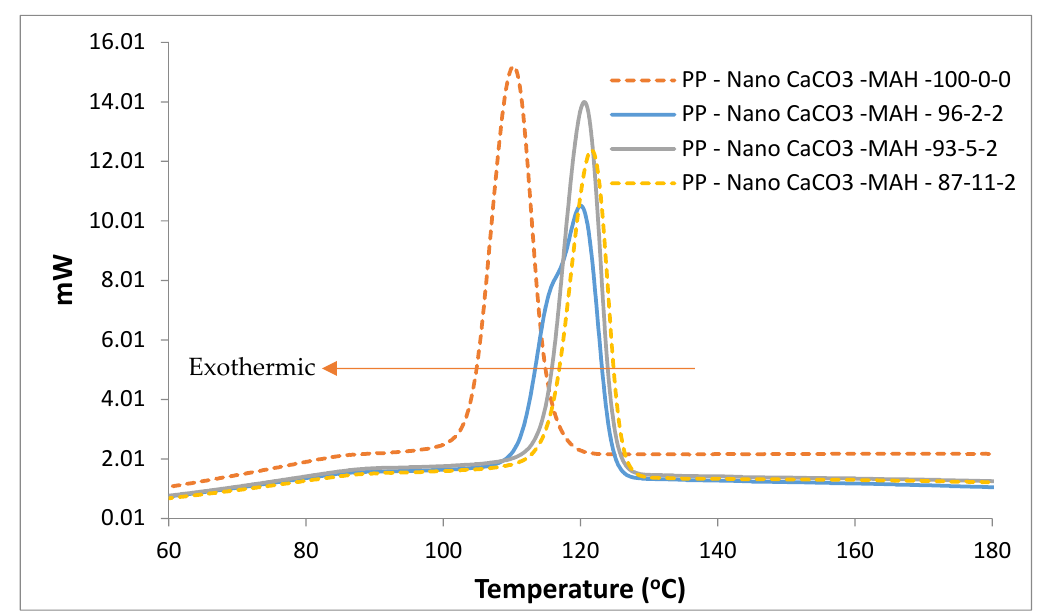
Figure 4. Cooling DSC crystallization curves for PP with different nano-CaCO 3 wt%. Table 2. DSC melting temperature of PP nanocomposite for different nano-CaCO 3 and MAH wt%.